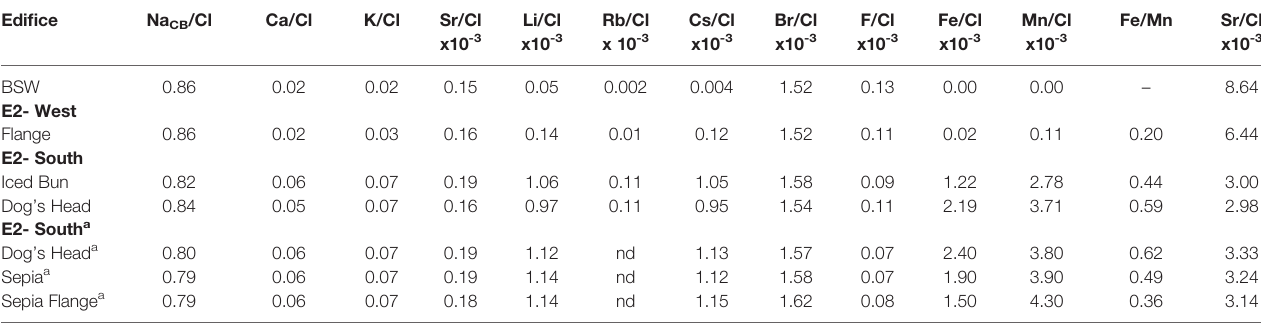
TABLE 4 | Molar element/Cl ratios for fl uids from ESR. E2-West ratios are calculated from measured concentrations, while E2-S are calculated from EM values. Edi fi ce Na CB /Cl